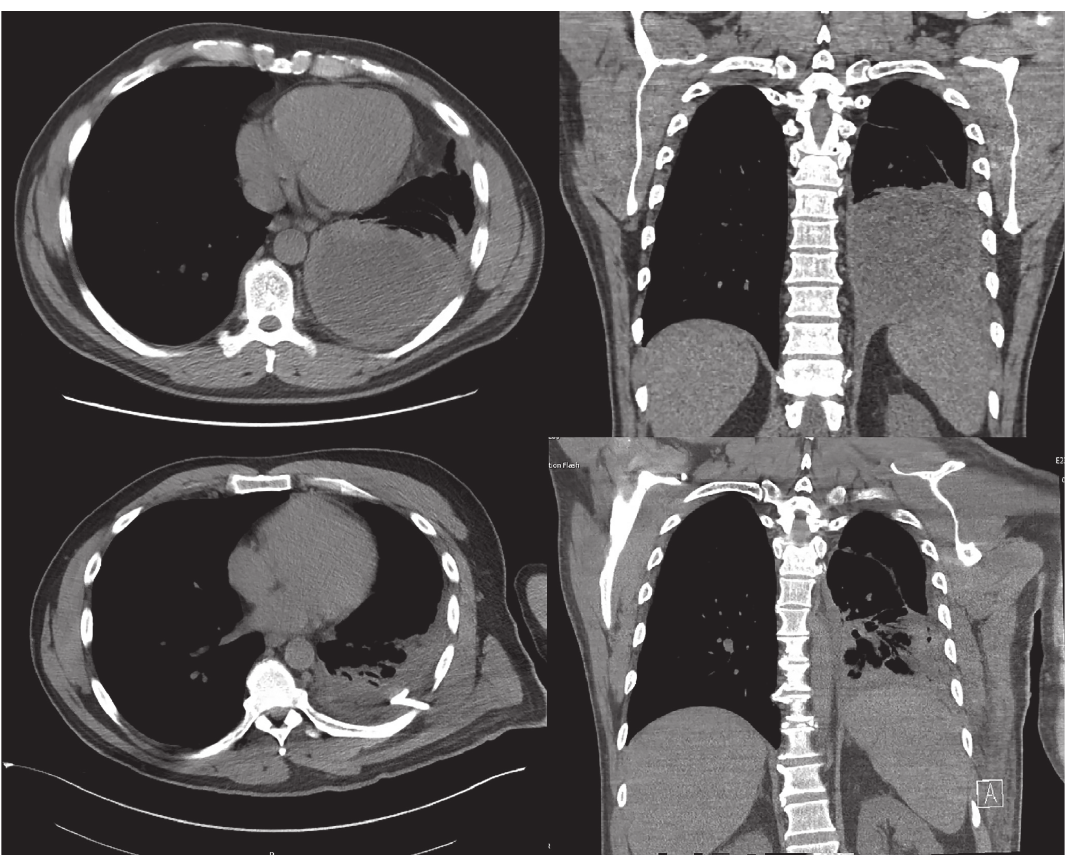
Figure 2: Chest CT showing left-sided pleural effusion, with follow-up chest CT demonstrating decreased fluid collection after systemic antibiotics and intrapleural fibrinolytic